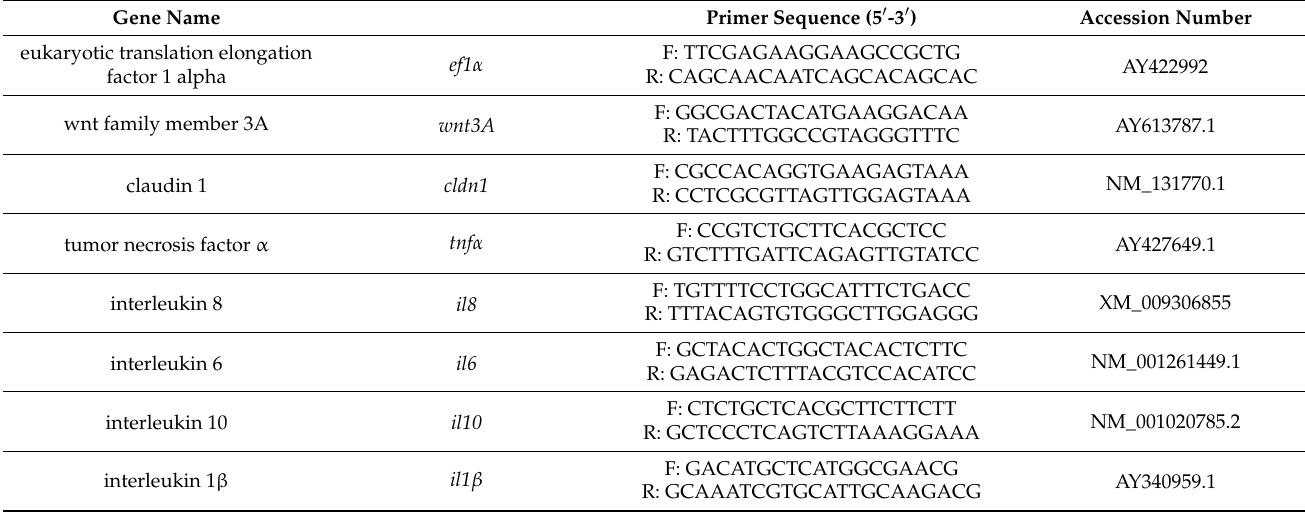
Table 2. Oligonucleotide primers used for quantitative RT-PCR analysis of gene regulation in response to STW 5 treatment in irritable bowel syndrome. F: forward; R: